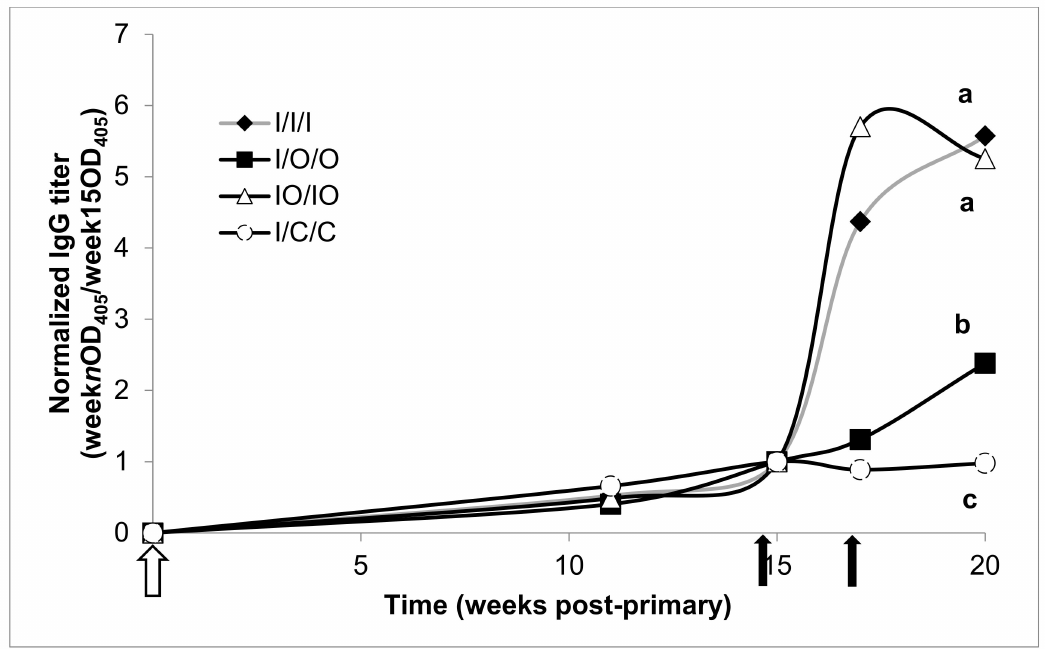
Figure 4. Serum anti-HBsAg IgG geometric means normalized to pre-boost titers. Treatment groups, arrows, and statistical analysis as in Figure